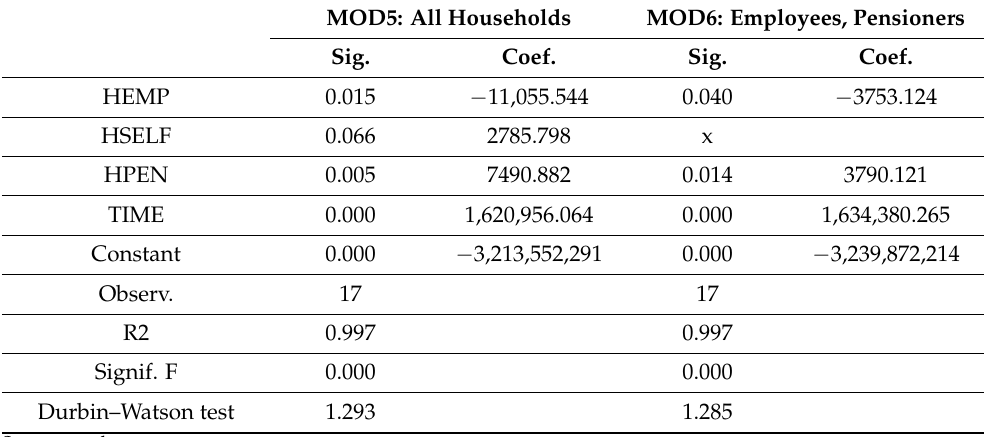
Table 7. Regression analysis—households model.